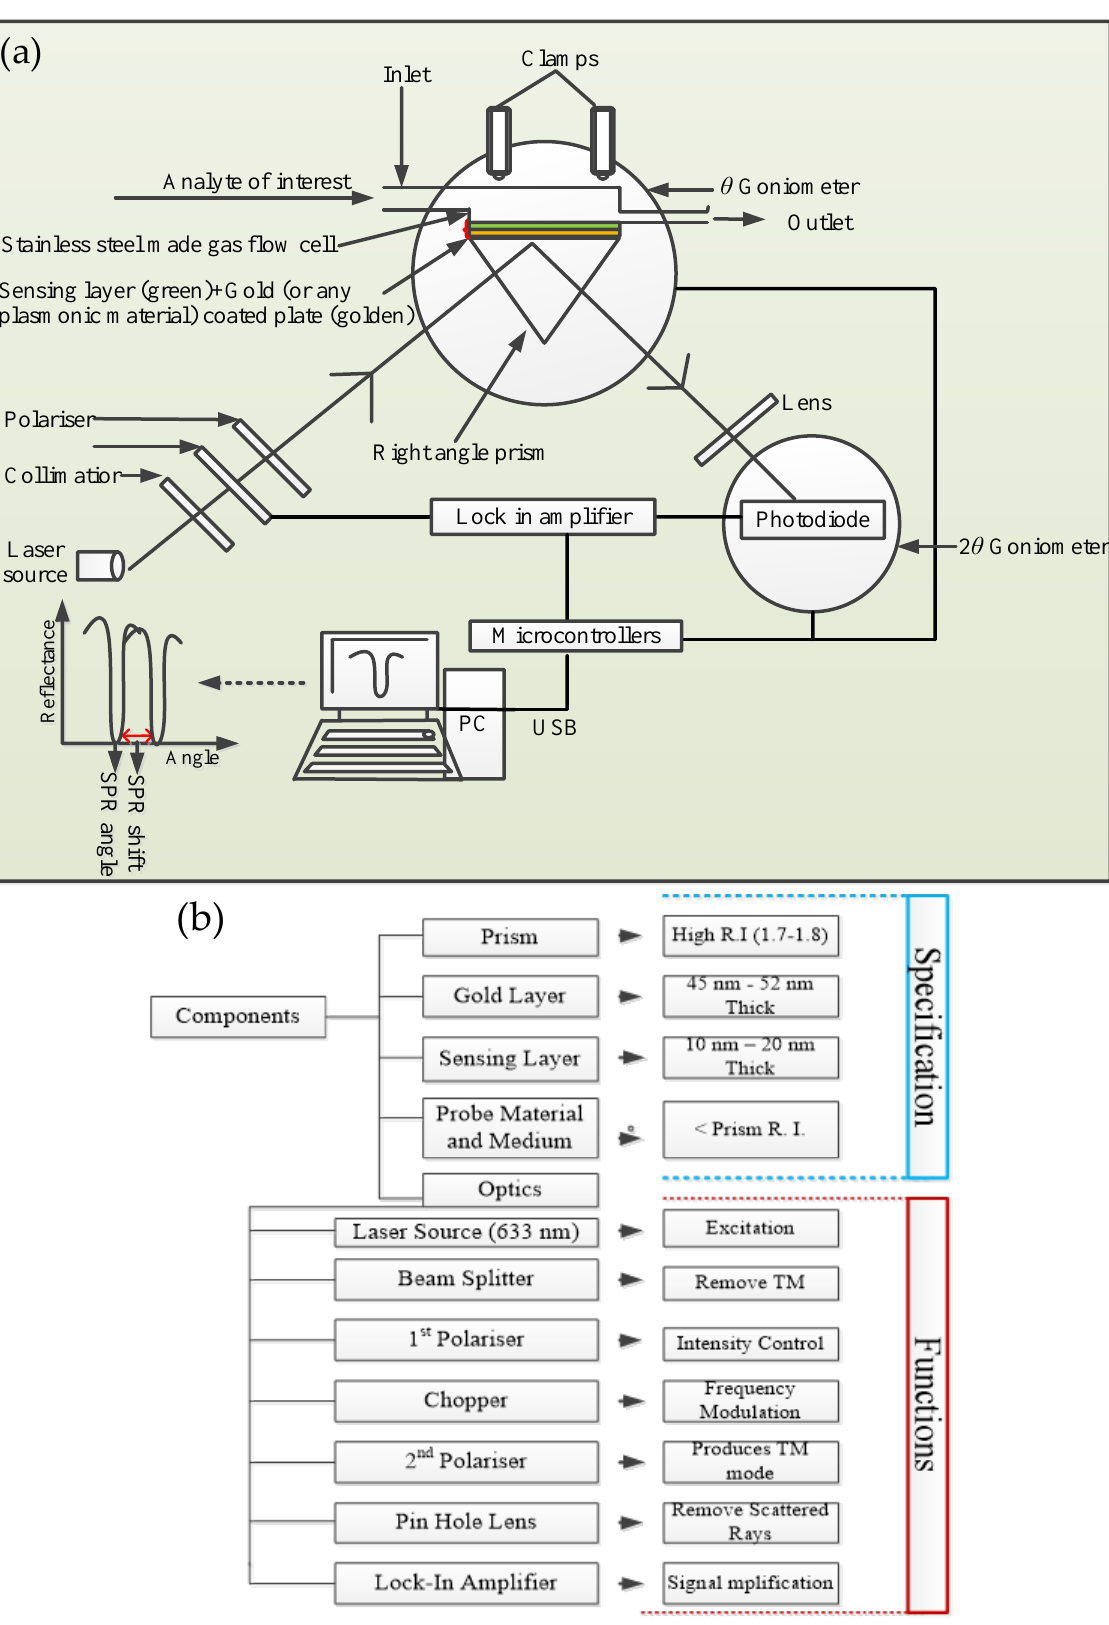
Figure 3. ( a ) Sketch diagram of a typical SPR biosensor system; ( b ) Components of SPR biosensor system and their functions.